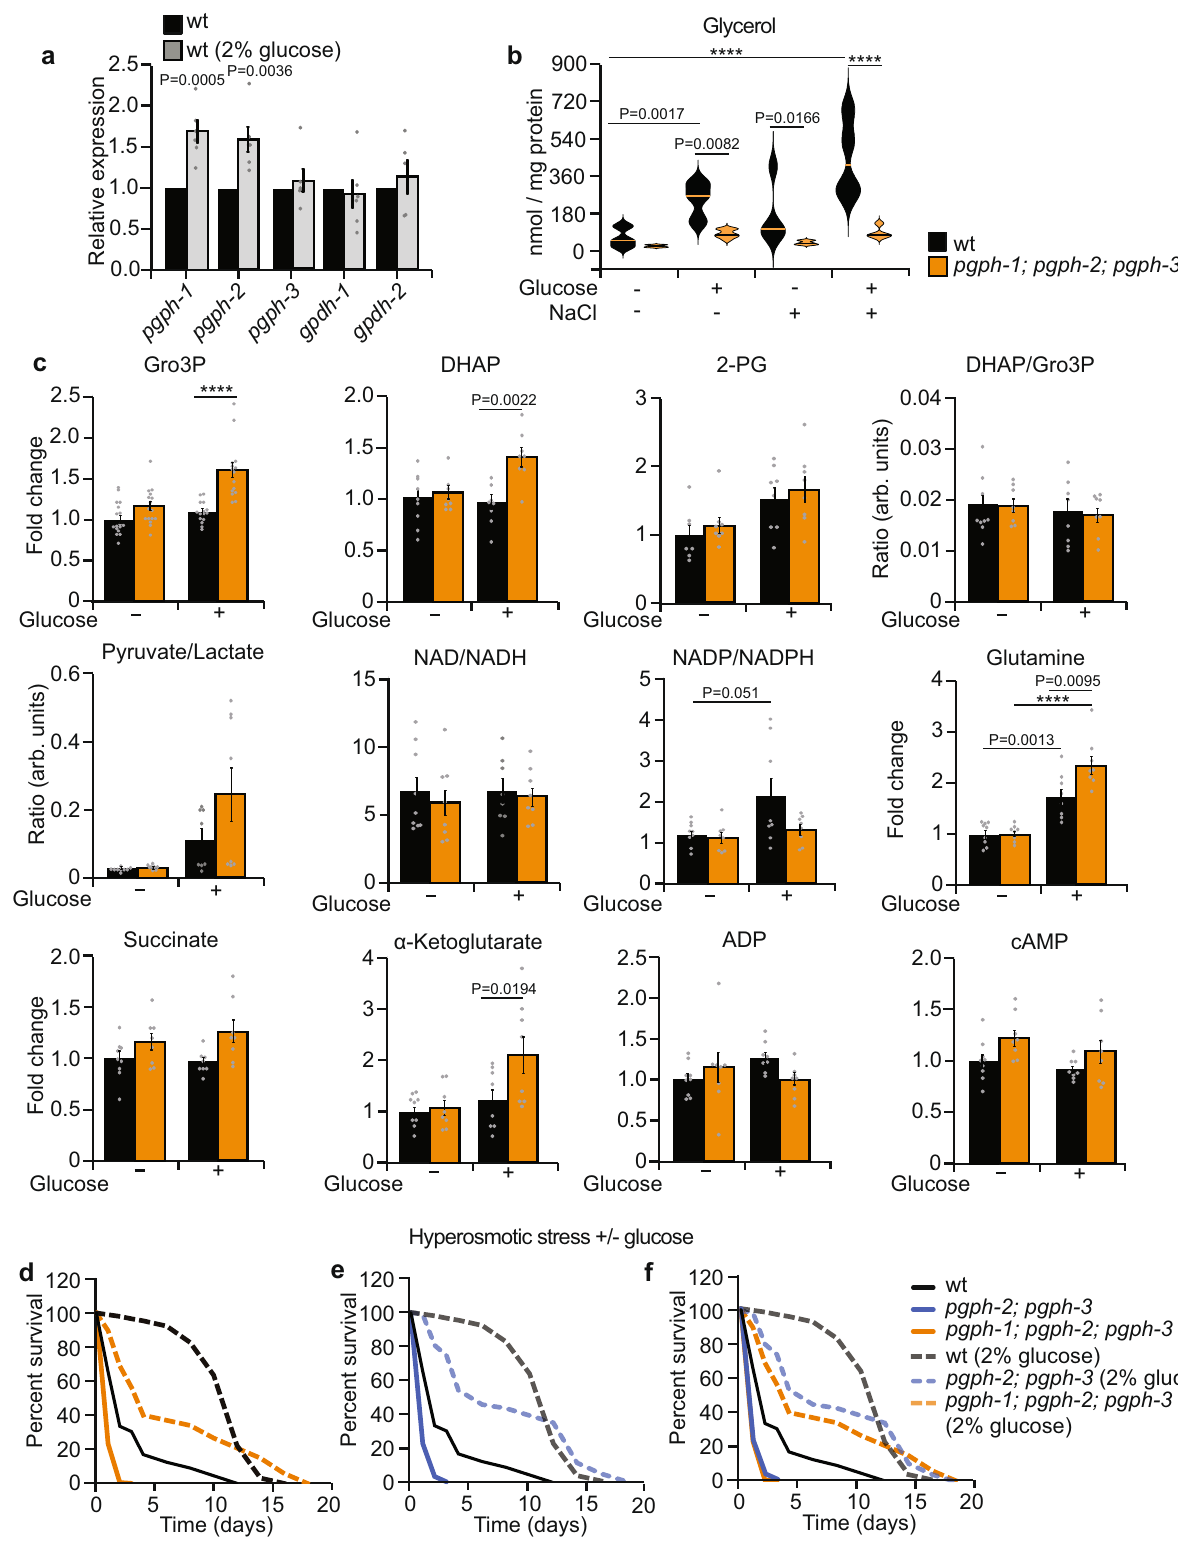
lipogenesis . Three separate transgenic lines overexpressing pgph- Supplementary Data 3). Video imaging of glucose-fed